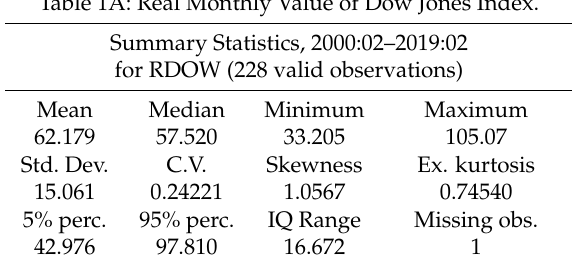
Table 1. Summary statistics. Table 1A: Real Monthly Value of Dow Jones Index.